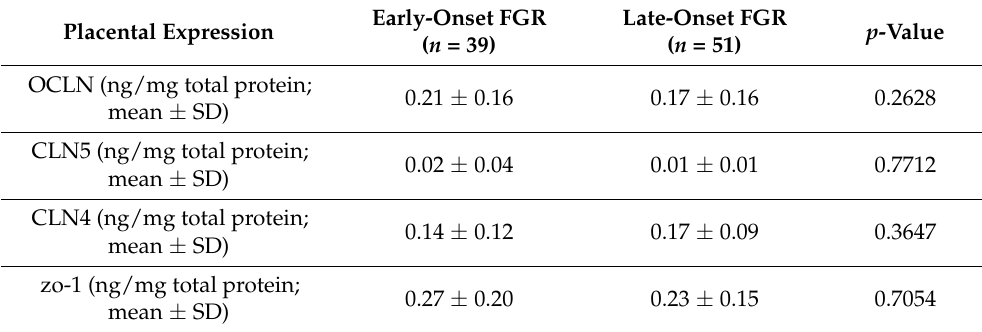
Table 4. The placental TJ proteins expression in pregnancy, complicated by the early-onset and late-onset